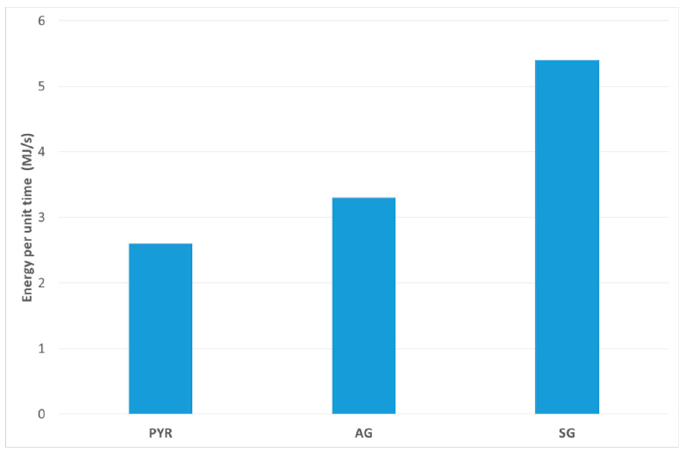
Figure 8. Energy per unit time (MJ/s) of syngas produced during the tests.